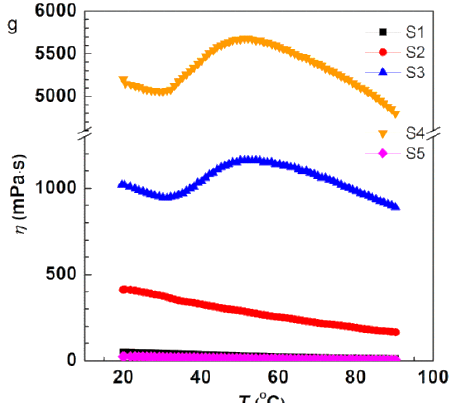
Figure 8. Apparent viscosity plotted as a function of temperature for S1, S2, S3, S4 and S5 at the same concentration in pure water: ( a ) 0.1 wt %; ( b ) 0.2 wt %; ( c ) 0.3 wt %; ( d ) 0.4 wt %; ( e ) 0.5 wt %; ( f ) 1.0 wt %; ( g ) 2.0 wt % (shear rate = 10 s − 1 ). Table 4. Thermoviscosifying ability of different polymers at five different concentrations.